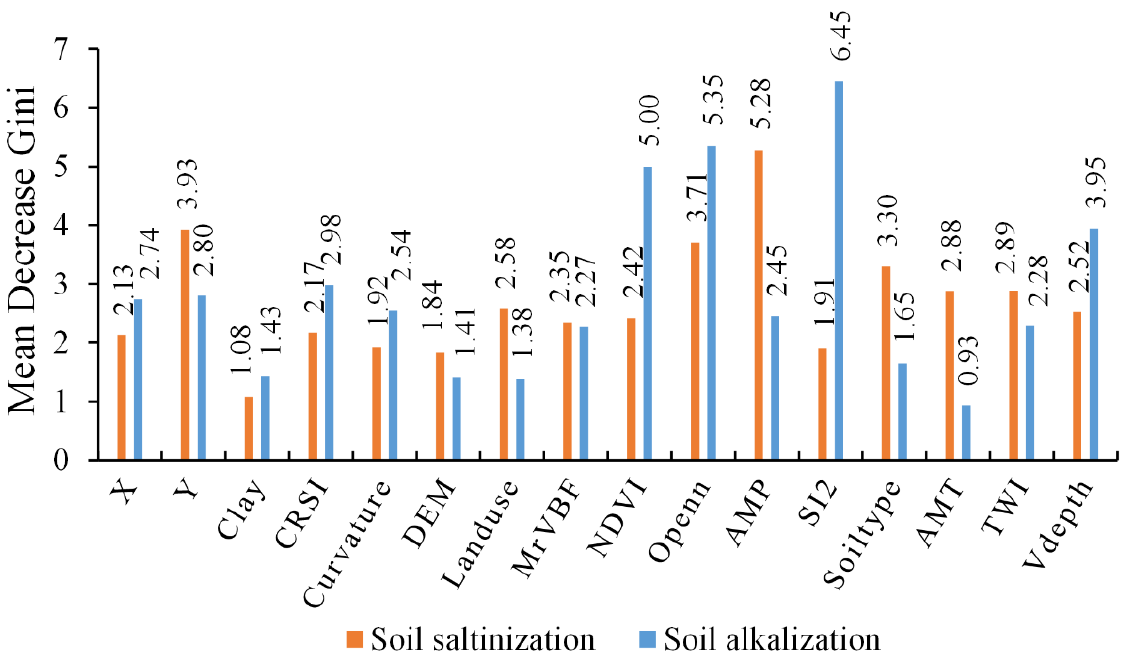
Figure 4. Mean Decrease Gini of each factor derived from the random forest.